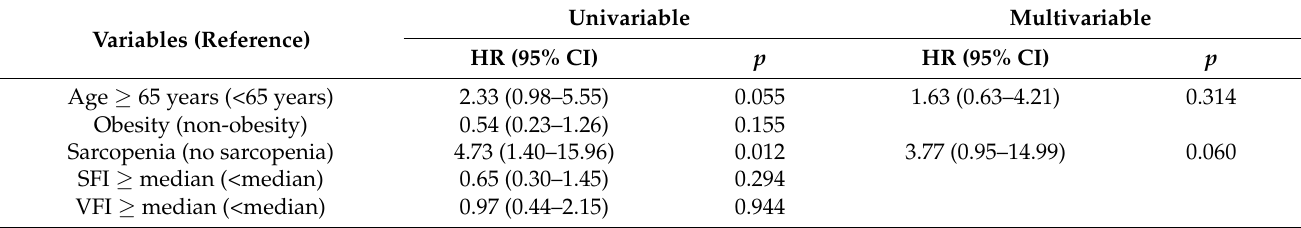
Figure 3. Kaplan–Meier estimates of radiographic progression-free survival ( A ), and rate of PSA progression ( B ) according to sarcopenic status. Censored data are marked at each line. PSA, prostate-specific antigen. Table 3. Results of Cox regression analysis for radiographic progression-free